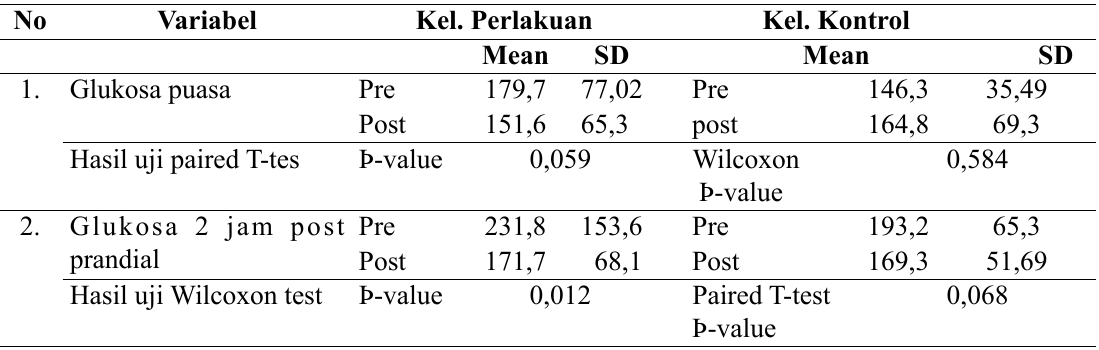
Tabel 6. Pengaruh Pemberdayaan Pasien Berbasis Experiential Learning terhadap kadar glukosa